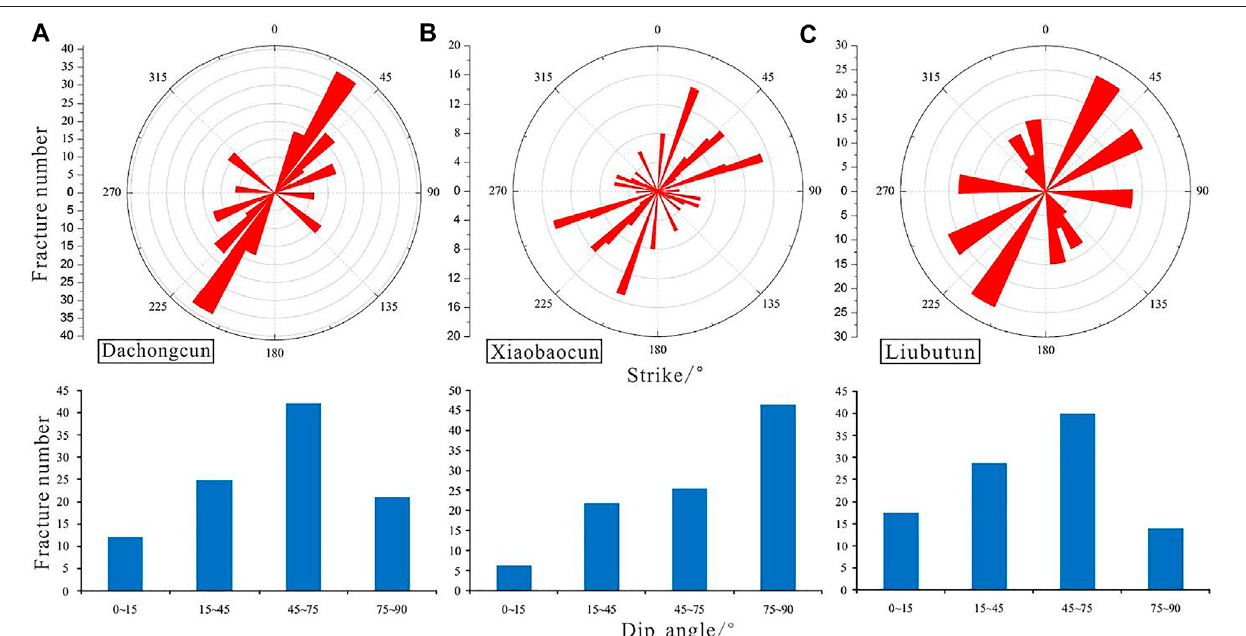
FIGURE 12 | Strikes and dips of structural fractures of Niutitang formation in three outcrops (Li et al., 2020).